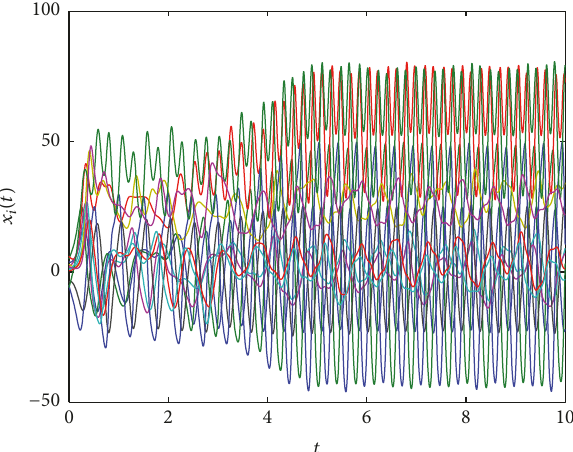
Figure 2: States of network (2) without control: 𝑥 𝑖 (𝑡), 𝑖 = 1, 2,3, 4.